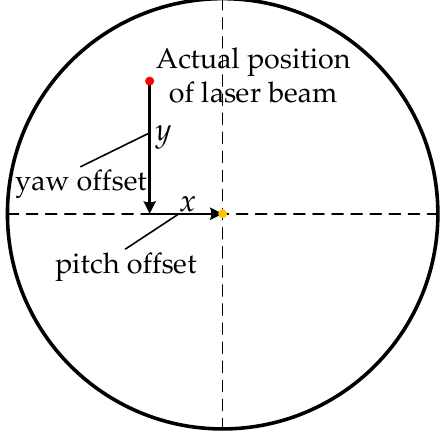
Figure 5. Signal detection on the array detector.